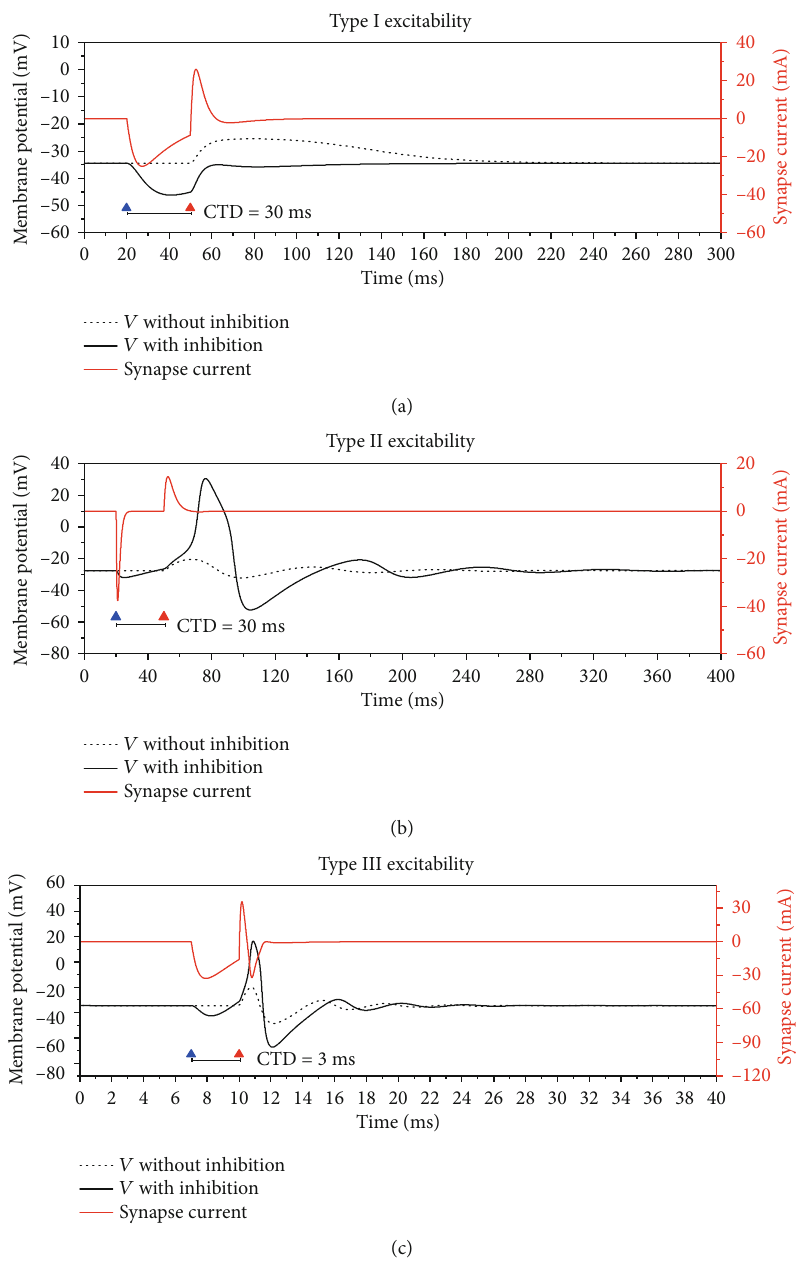
Figure 1: The responses of the membrane potential. Black dashed curve represents the response to an excitatory stimulation (red triangle) and black solid curve to a pair of inhibitory stimulation (blue triangle) and excitatory stimulation. The red curve represents the inhibitory and excitatory stimulations. (a) The PIF phenomenon does not appear for type I excitability. Inhibition stimulation ( G inh = 1 mS/cm 2 ) at t = 20 ms and excitation stimulation ( G = 1 : 1 mS/cm 2 ) at t = 50 ms . (b) The PIF phenomenon for type II excitability. Inhibition ex stimulation ( G inh = 1 mS/cm 2 ) at t = 20 ms and excitation stimulation ( G ex = 1 mS/cm 2 ) at t = 50 ms . (c) The PIF phenomenon for type III excitability. Inhibition stimulation ( G inh = 0 : 6 mS/cm 2 ) at t = 7 ms and excitation stimulation ( G ex = 2 : 5 mS/cm 2 ) at t = 10ms